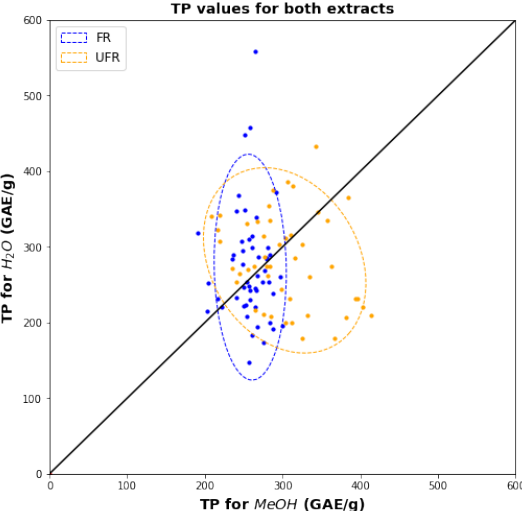
Figure 2. Scatter diagram showing FR and UFR TPCs for water versus